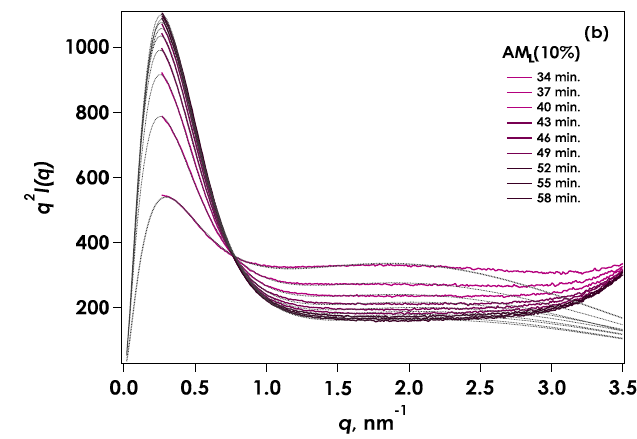
Figure 5. Kratky plots [ q 2 I ( q ) vs. q ] for SAXS from AM L . Dotted lines are fitted curves calculated from Equation (1). ( a ) Initial stage of reaction (1–31 min); ( b ) Final stage of reaction (34–58 min).